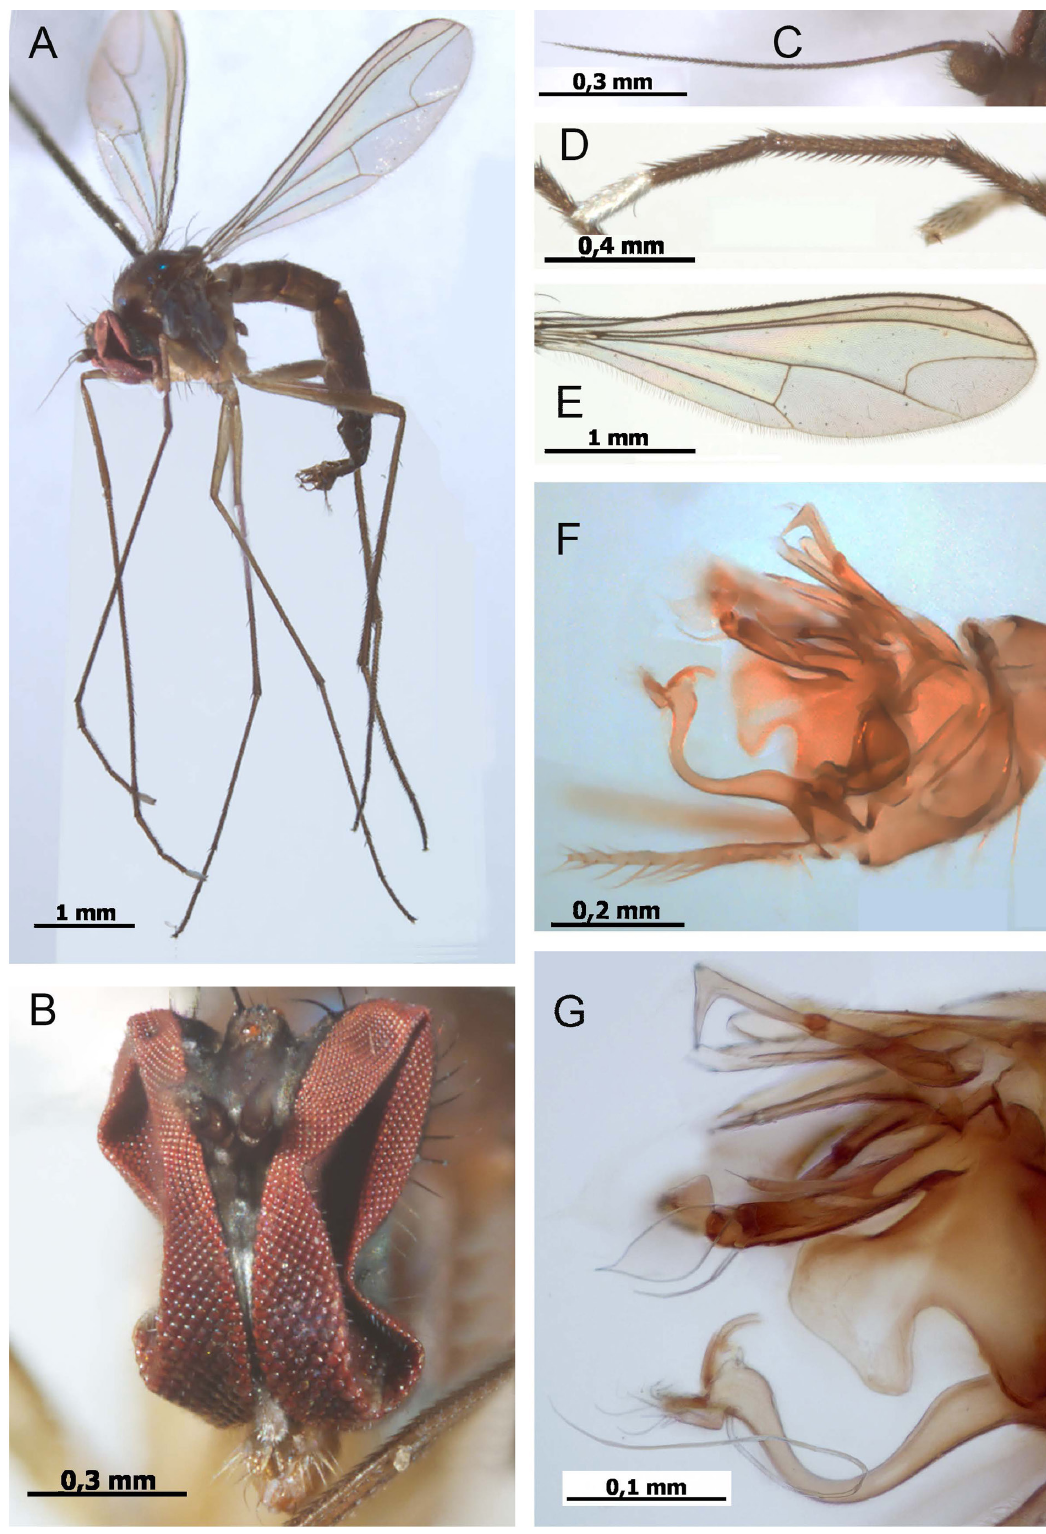
Fig. 7. Amblypsilopus analamazaotra sp. nov. A–E . Holotype, ♂ (SMNHTAU). F–G . Paratype, ♂ (SMNHTAU). A . Habitus. B . Head. C . Antenna. D . Fore tarsomeres 2–5. E . Wing. F . Hypopygium, left lateral view, reflected light. G . Distoventral appendages of hypopygium, transmitted